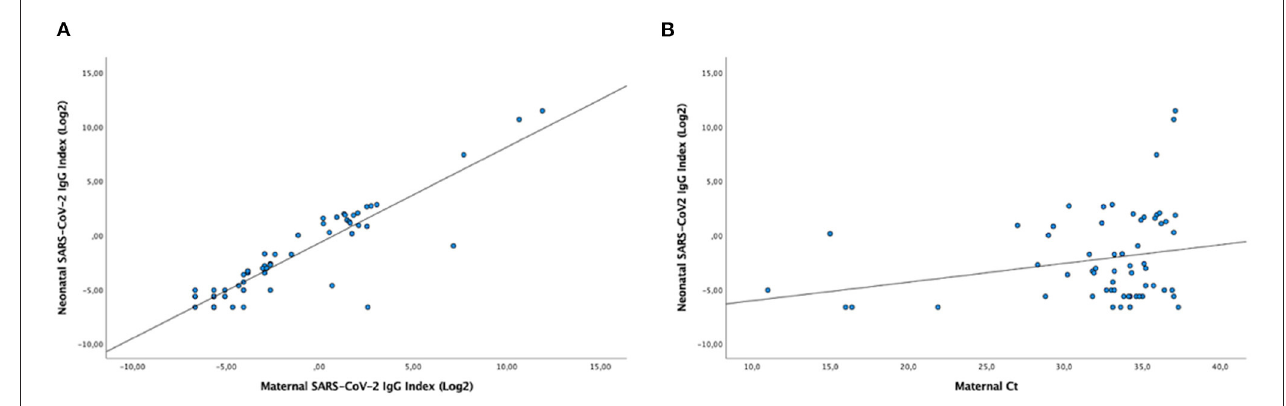
FIGURE 2 | T Correlation between cord blood seropositivity and maternal seropositivity (A) or cord blood seropositivity and maternal Ct values at delivery (B) . Scatterplots show the distribution of SARS-CoV-2 IgG levels as an index value based on the ratio of sample absorbance to the absorbance of an assay-specific calibrator or control (S/C) units at the time of delivery. (R = 0.851, P < 0.0001 and R = 0.228, P = 0.075, for a and b, respectively; Pearson Correlation).